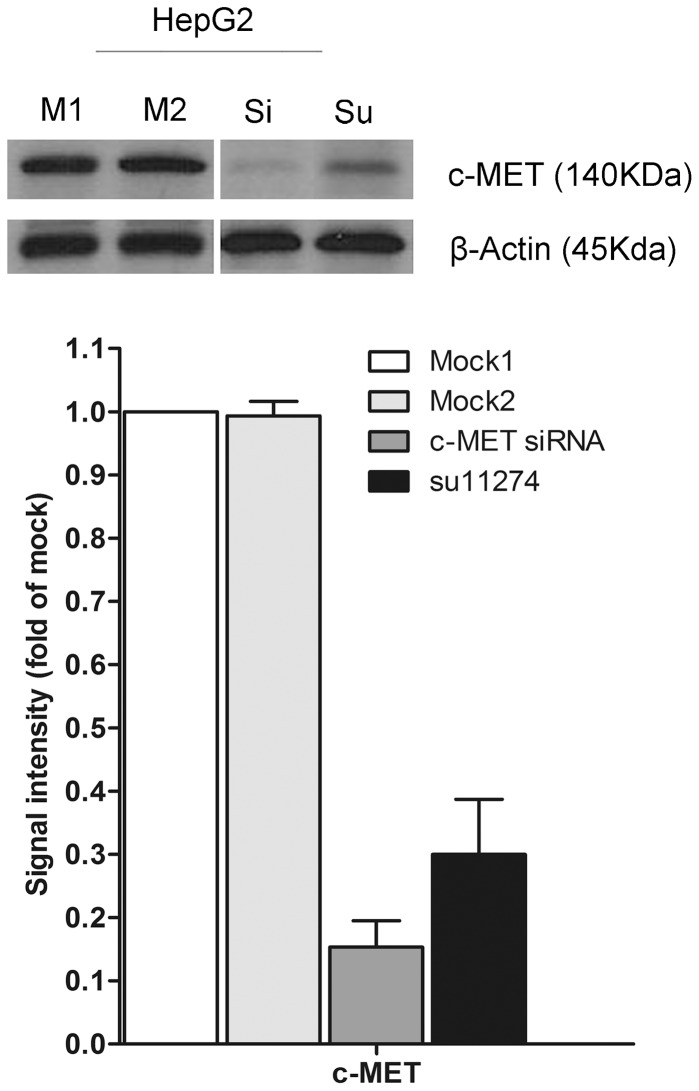
Protein level of c-MET after treatment of siRNAs or small molecular inhibitor su11274.HepG2 cells (2.5×104 cells per well using 24-well-plate) were transfected with c-MET siRNAs or treated with c-MET small molecular inhibitor su11274 for 96 h. c-MET protein level was determined using western blot. c-MET and β-actin western blot signals were quantified, and the c-MET signal intensity relative to the β-actin was calculated. These values are represented by the bar graph. M1:Mock1, mock control for siRNA containing only transfection reagent; M2: Mock2, mock control for su11274 with only 0.1% DMSO. Si: c-MET siRNAs. Su: su11274.